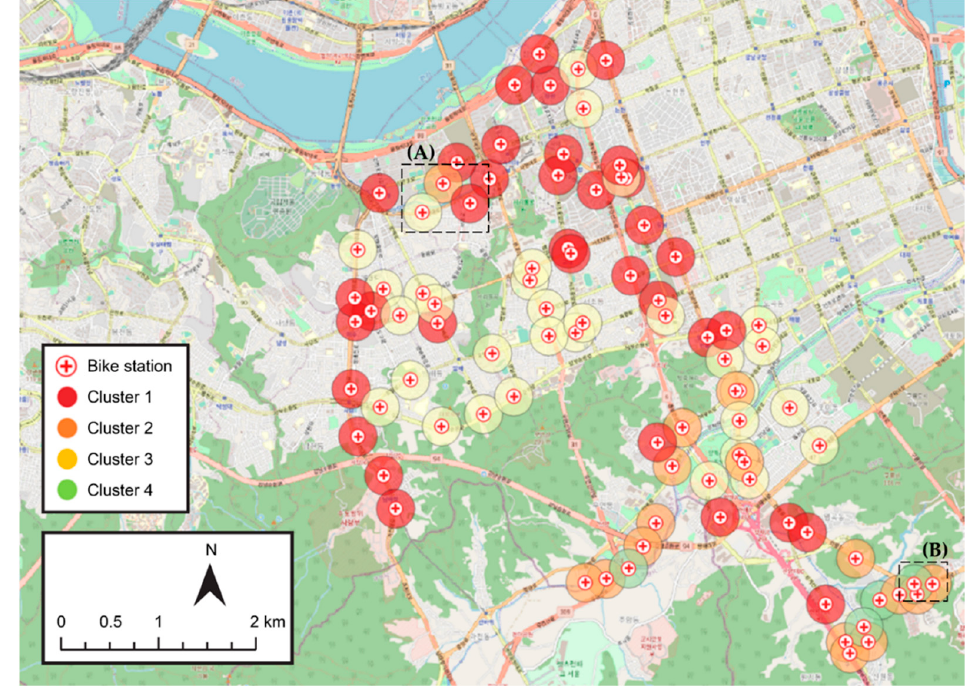
Figure 8. Results of the final clustering.